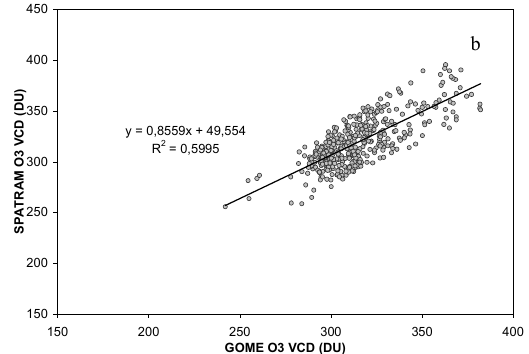
Figure 4. a) Time series of the O 3 VCD obtained with the SPATRAM equipment installed at Évora Observatory during Table 1 . Correlation analysis of SPATRAM, GOME and 2007-2011, and the O 3 data from the GOME instrument aboard SCIAMACHY total ozone data for the period of 2007-2011. the ERS-2 satellite. b) The correspondent scatter plot of the O 3 data from the GOME instrument versus O 3 SPATRAM data retrieved at the same period including the regression line (black From the analysis of Table 1 it can be inferred that in most days line). the SPATRAM values are lower than the ones obtained with other sensors. Therefore there is an underestimation of